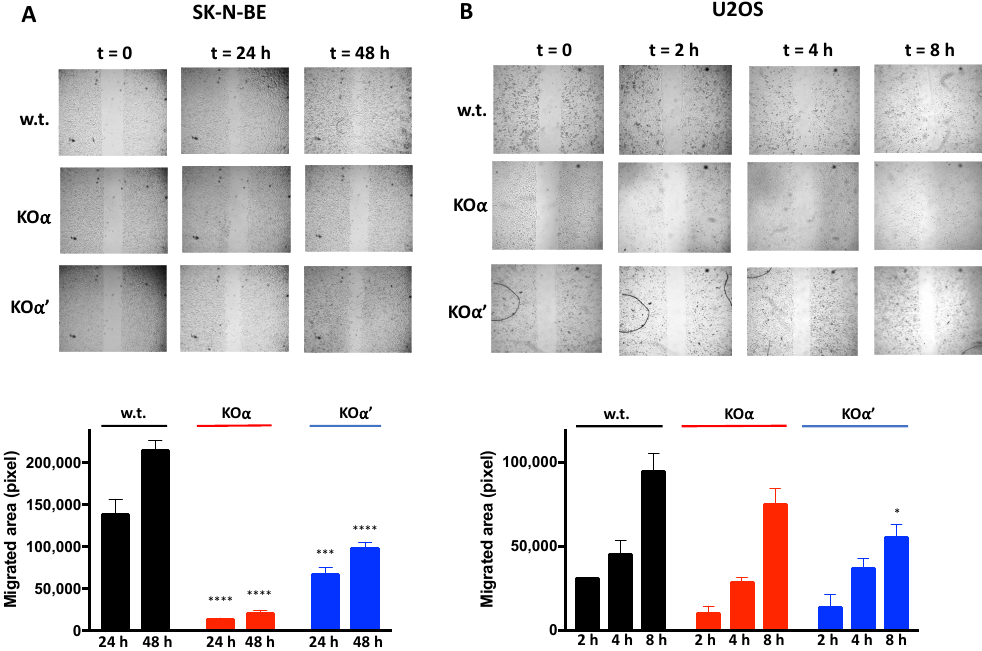
Figure 5. Migration of w.t. and KO clones of ( A ) SK-N-BE (KO α clone 1, KO α ’ clone 1) and ( B ) U2OS (KO α clone 1, KO α ’ clone 2) cells. Cell migration was assessed by wound-healing assay. Images were taken at the indicated times after the removal of the insert (t = 0). The experiments were performed three times. Representative images are shown. The bar graphs on the bottom show the quantification of the migrated areas of at least 2 different experiments, each one performed in triplicates (see Section 2 for details). Significance refers to the corresponding time in w.t. cells. (*) p < 0.05, (***) p < 0.001, (****) p <